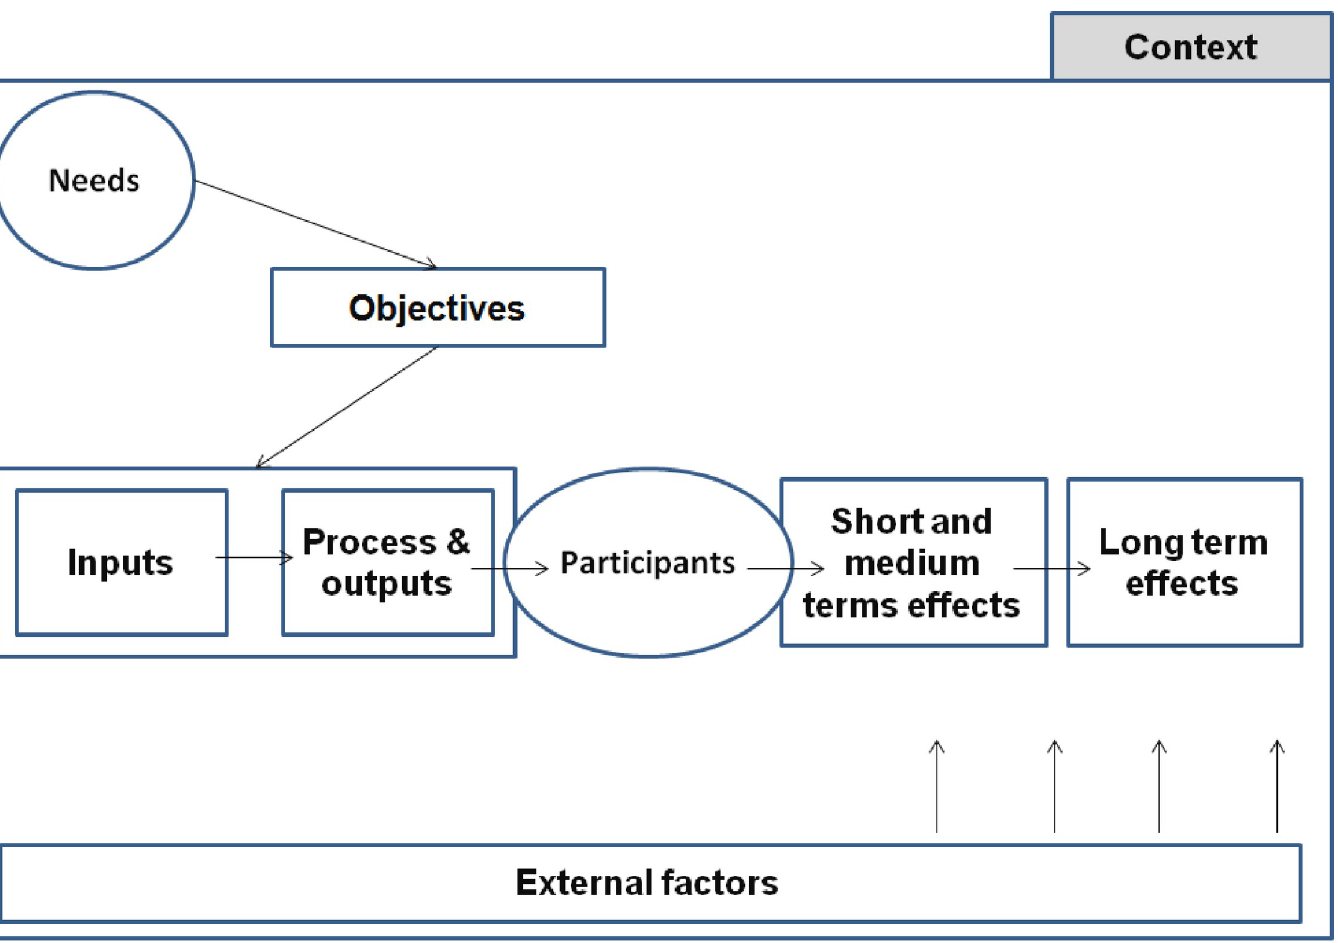
Fig 1. Logic model representation and its components (inspired by Ridde & Dagenais,